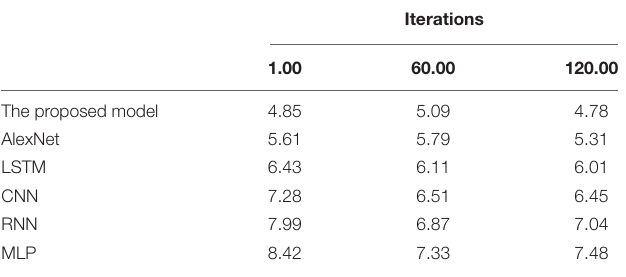
TABLE 2 | MAE (%) changes of each model with